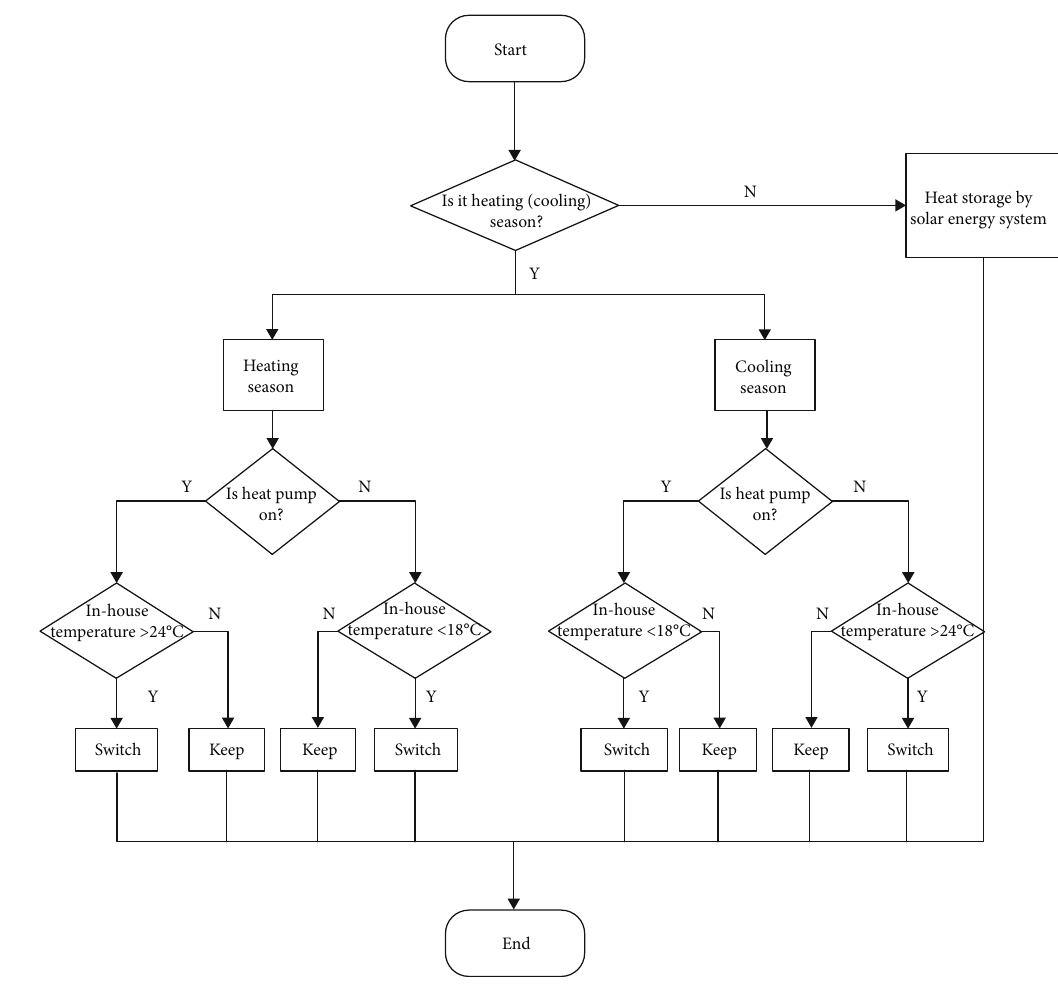
Figure 9: Control strategy of the system.